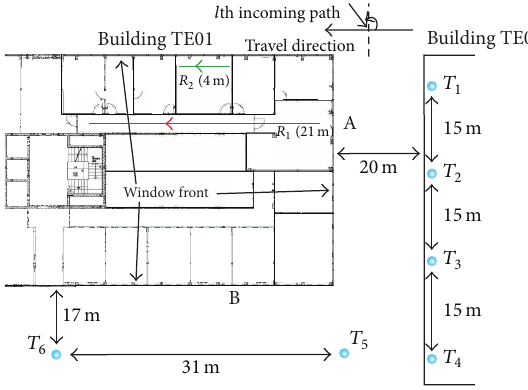
Figure 1: Environment layout of